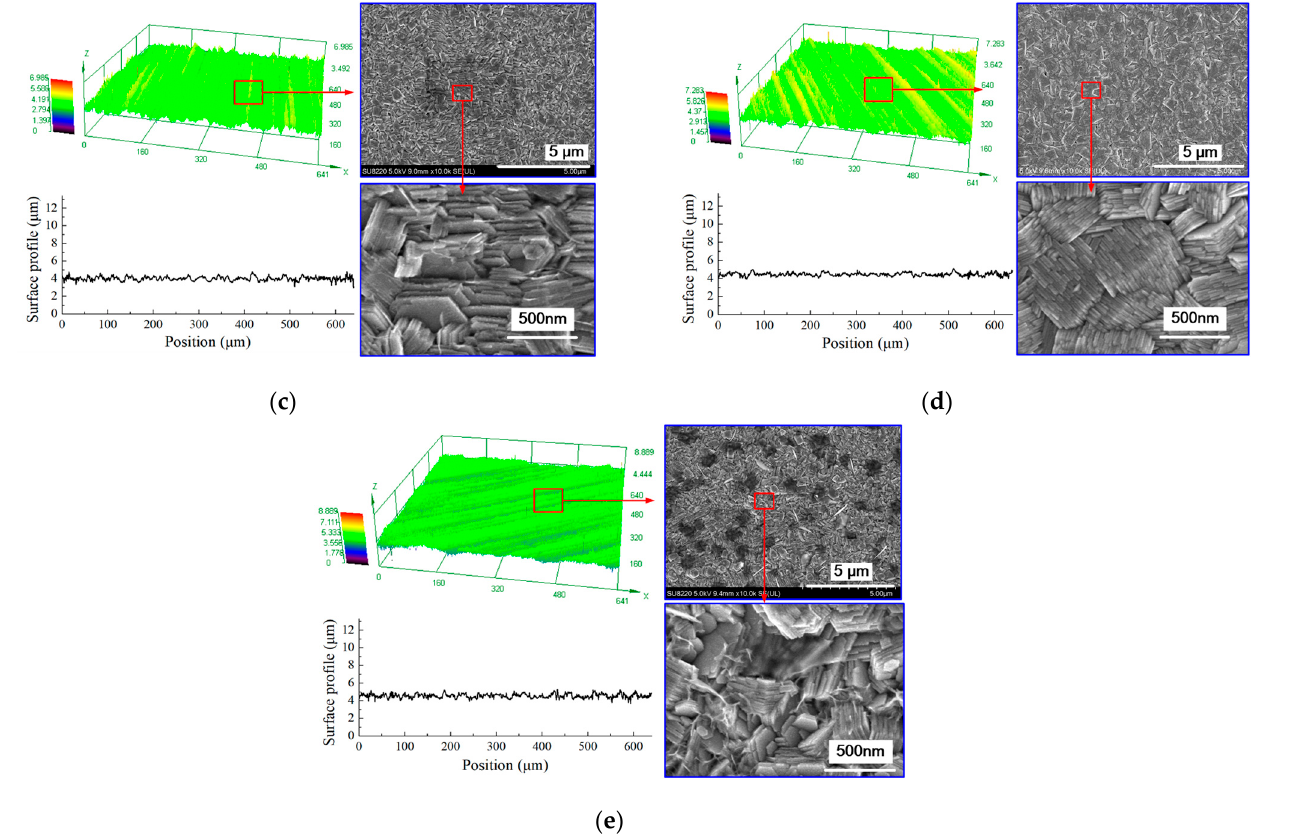
Figure 10. The surface morphology of the deposited coating at different current densities. ( a ) i = 0.125 A/dm 2 ; ( b ) i = 0.25 A/dm 2 ; ( c ) i = 0.375 A/dm 2 ; ( d ) i = 0.5 A/dm 2 ; ( e ) i = 0.625 A/dm 2 .